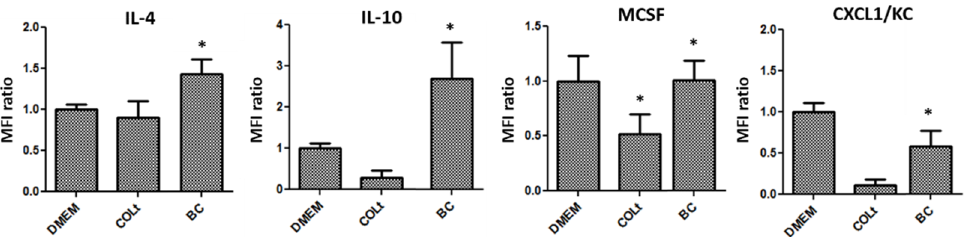
Figure 9. Expression of M2 macrophage-related cytokines secreted by macrophages cultured on bacterial cellulose (BC) scaffold, collagen total type material (COLt), or in DMEM for 24 h (IL-4 = interleukin-4; IL-10 = interleukin-10; MCSF = macrophage colony-stimulating factor; CXCL1/KC = chemokine (C-X-C motif) ligand 1/keratinocyte-derived chemokine; * p < 0.05).